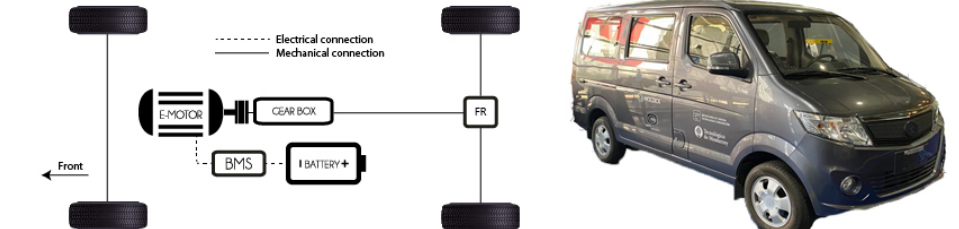
Figure 2. Platform configuration of a rear-wheel-drive electric vehicle with gearbox and differential (Final ratio FR) used in this work.